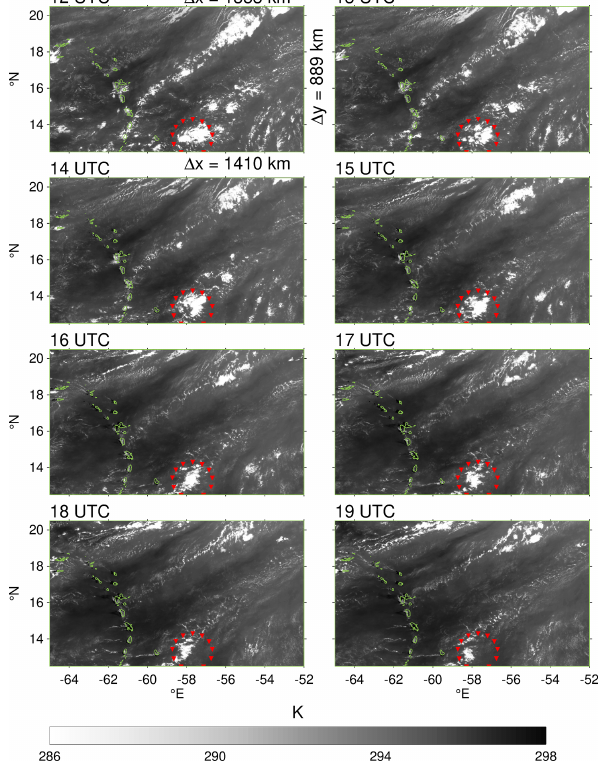
Figure 9. GOES-16 images from 31 January 2020, on a regu- lar longitude–latitude grid. The top edge of the images measures 1358km, the bottom edge 1410km, and the sides 889km. Shown are brightness temperatures from the C13 channel. Green outlines show the Caribbean Islands, and red triangles the locations of HALO’s